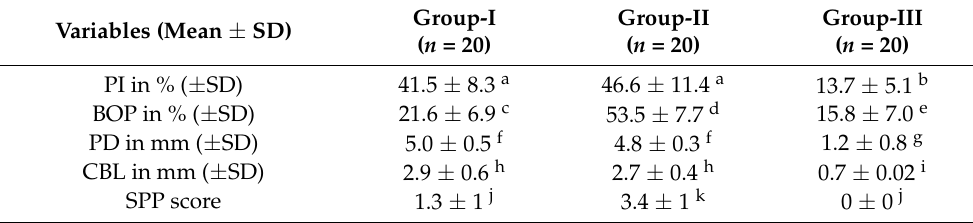
Table 2. Peri-implant clinical parameters of the research groups.